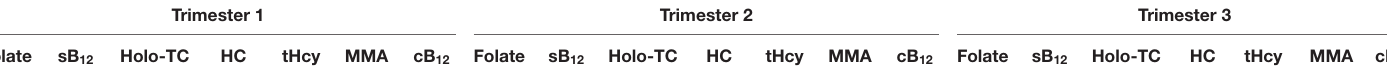
TABLE 2 | Correlation matrix of vitamin B 12 status biomarkers, cB 12 and [HoloTC: sB 12 ] in trimesters 1, 2 and 3 of